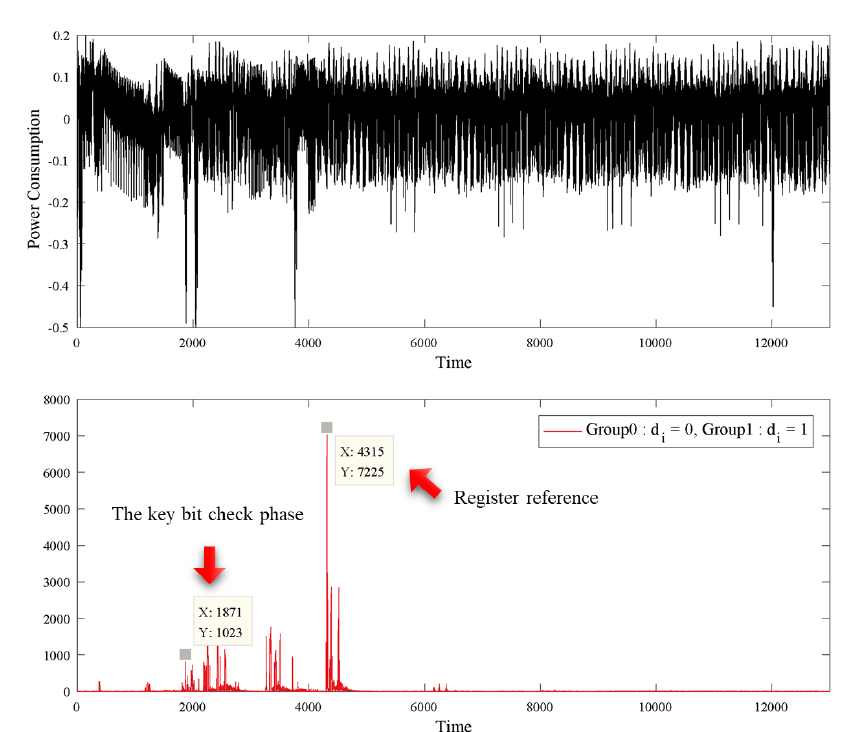
Figure A2. Software implementation (OpenSSL) acquisition range.